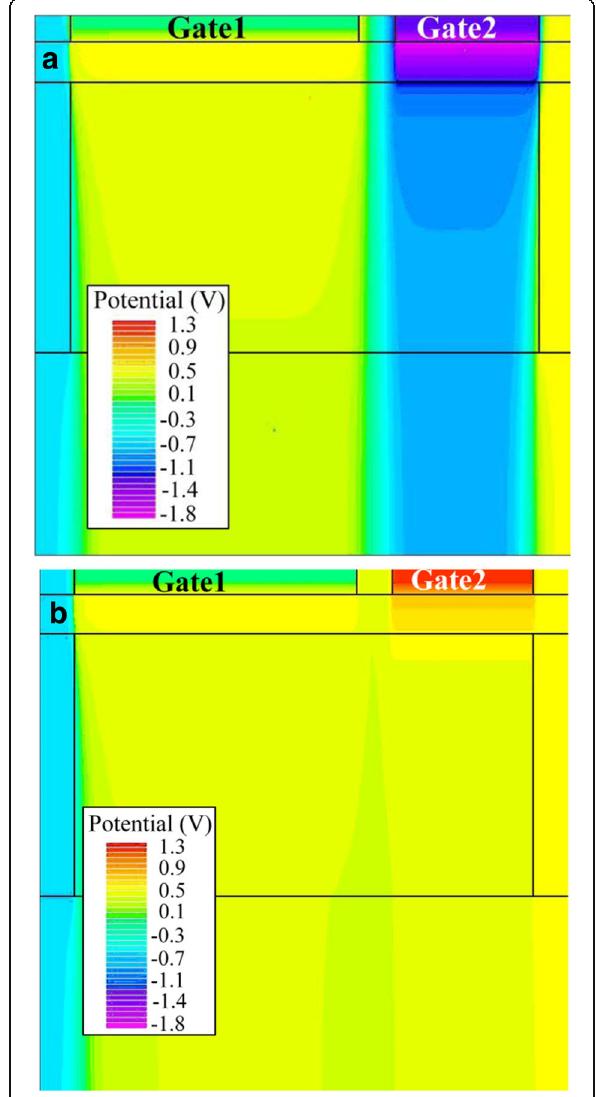
Fig. 4 Potential contours after a writing “ 1 ” and b writing “ 0 ” when the absolute value of Gate2 voltage is 1.3 V. a , b The potential contours after writing “ 1 ” and writing “ 0 ” , respectively. The potential contours in this figure are extracted when the absolute value of Gate2 voltage is set to 1.3